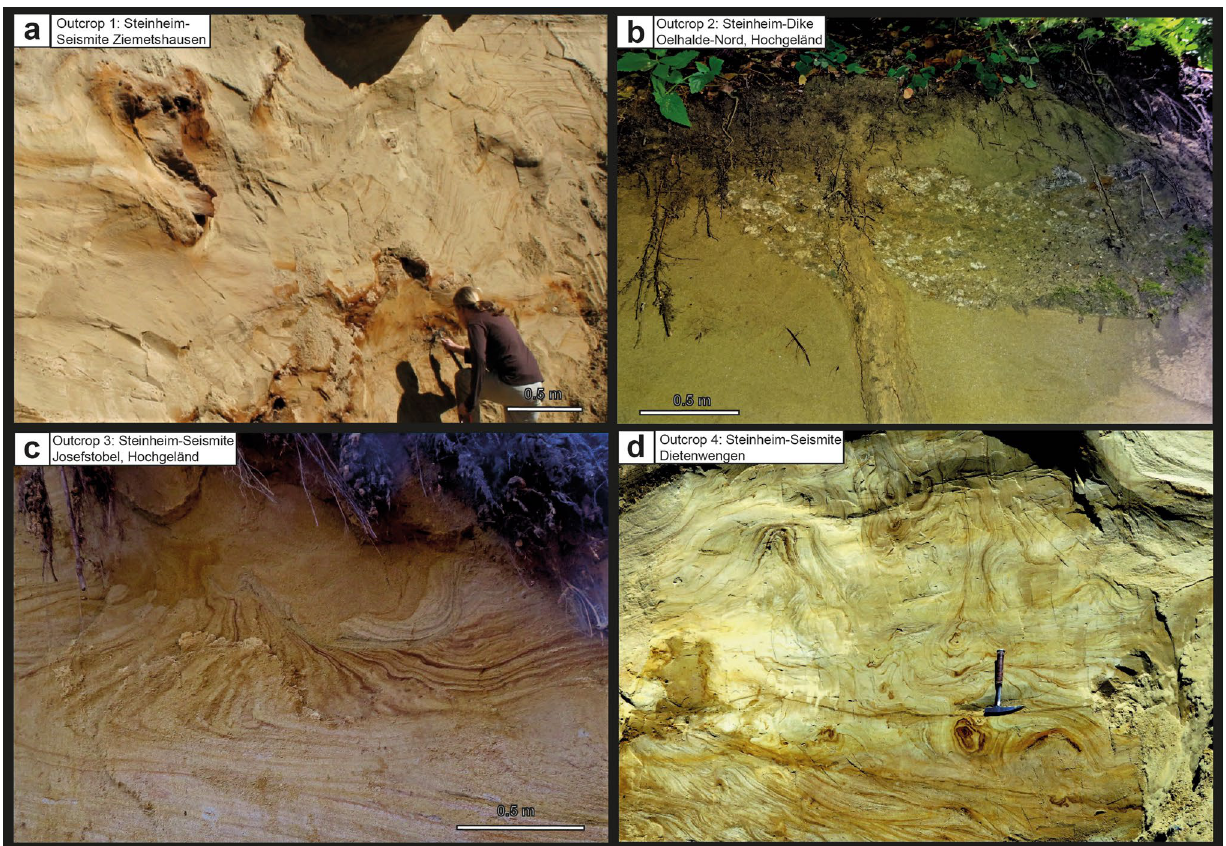
Figure 7. Photographs of the details of the Steinheim seismite and clastic dikes from the four outcrops discussed in the present study; ( a ) The 4–5 m-thick Steinheim seismite in the Ziemetshausen sand pit with slumps in the upper parts and convolute bedding in the lower parts of the seismite. A reworked (secondary) layer of distal Ries ejecta is integrated into folding of convolute bedding and clearly demonstrates that the upper seismite horizon is of post-Ries age; ( b ) Giant clastic dike cross-cutting a horizon of reworked OSM material approximately 2–3 m above the Ries seismite and distal Ries ejecta in the Tobel Oelhalde-Nord (Hochgeländ); ( c ) Slump in the Steinheim seismite from the Josefstobel (Hochgeländ plateau south of Biberach an der Riß); ( d ) Ball-and-pillow structures in the upper (Steinheim) seismite horizon at the Dietenwengen sand and gravel pit, hammer for scale. Photograph ( a ) was taken by E.B. in 2008; photographs: ( c )and ( d ) were taken by V.J.S. in 2021 ( b in